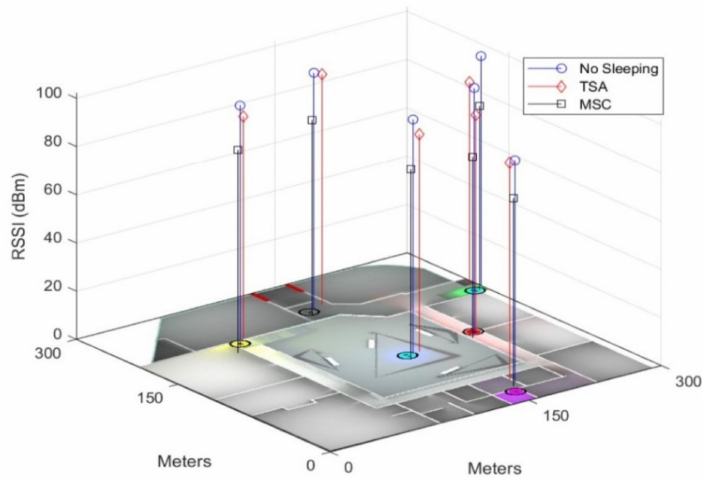
Figure 7. Analysis of the Zigbee sensors under no sleeping, TSA, and MSC for AODV (reactive